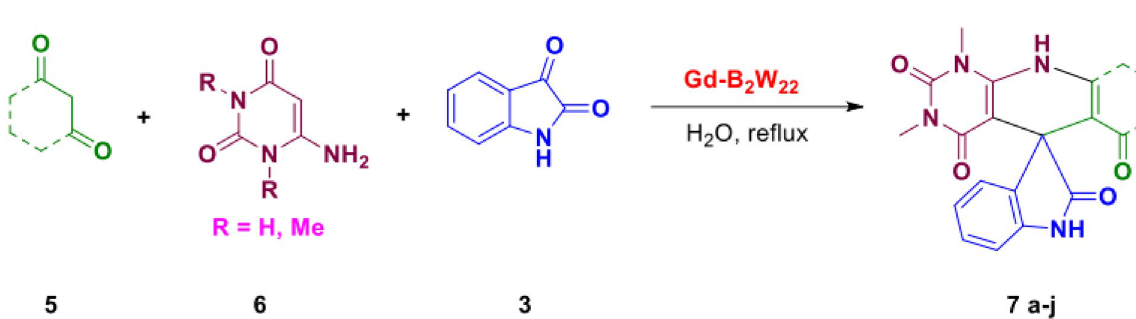
Figure 3. Synthesis of spiro-2-amino-4H-pryans.